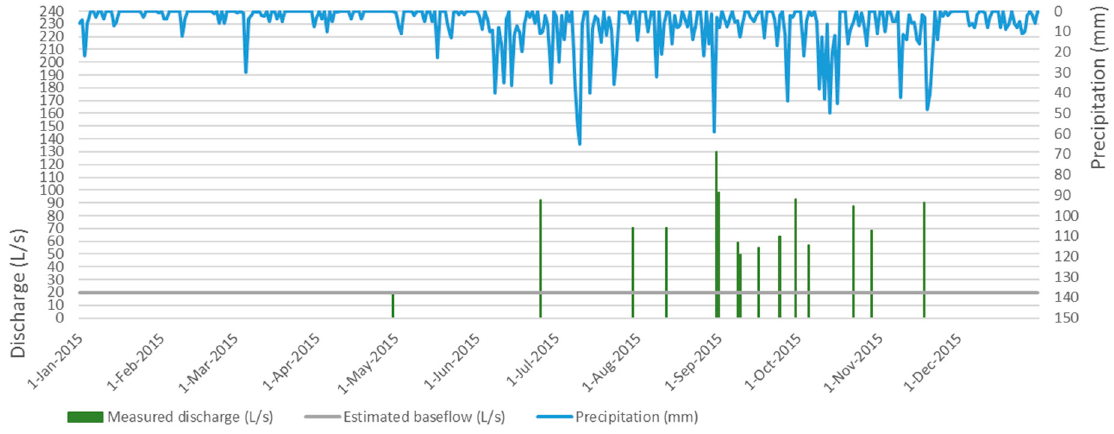
Figure 3. Discharge and precipitation measurements in 2015.